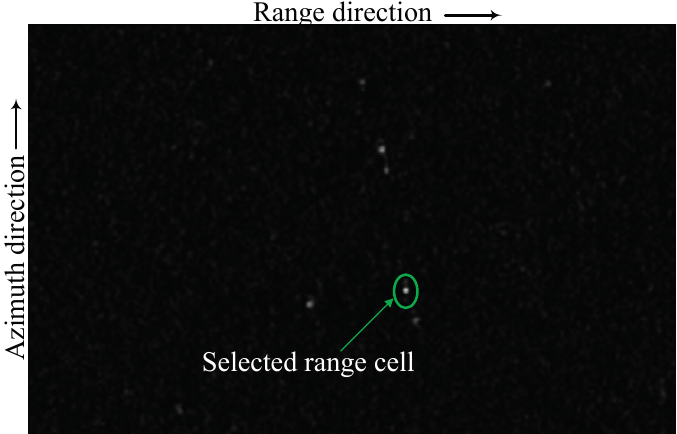
Figure 7. Results of factored space-time adaptive processing (STAP)